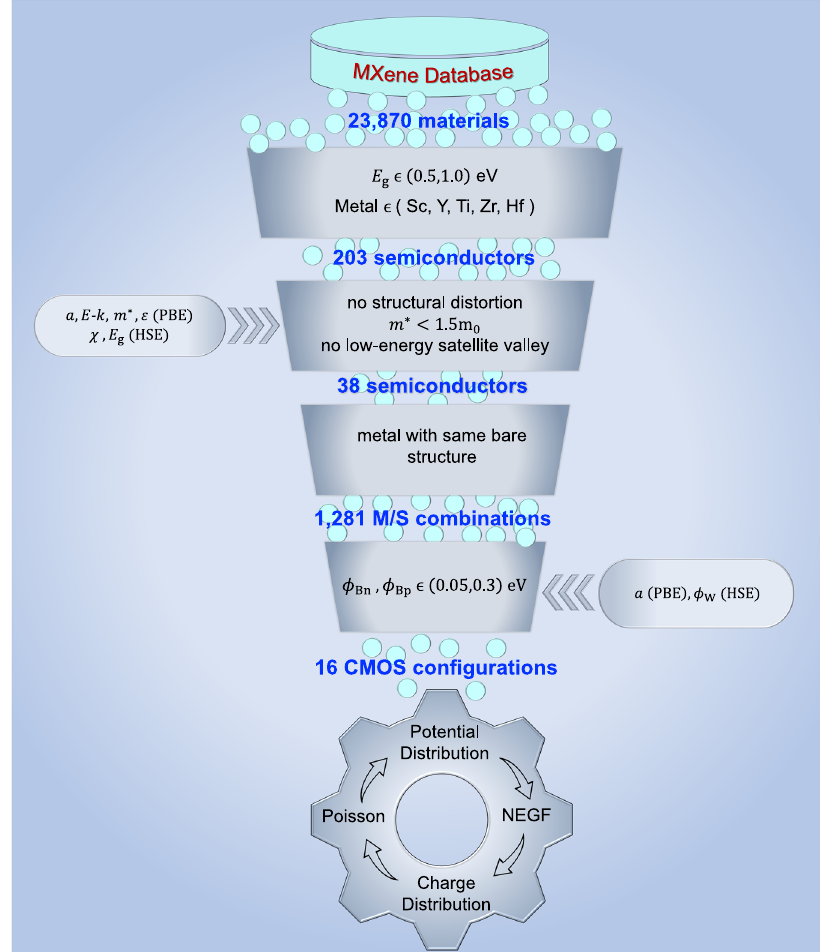
Fig. 3 High-throughput computational pipeline to screen suitable MXene materials for transistor applications and assess their electrical